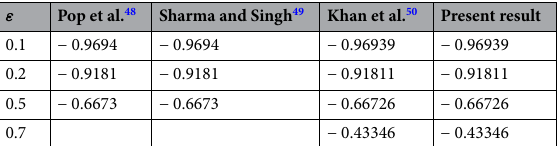
Table 4. Comparisons of stretching ratio (ε) when W e Singh 49 , and Khan et al. 50